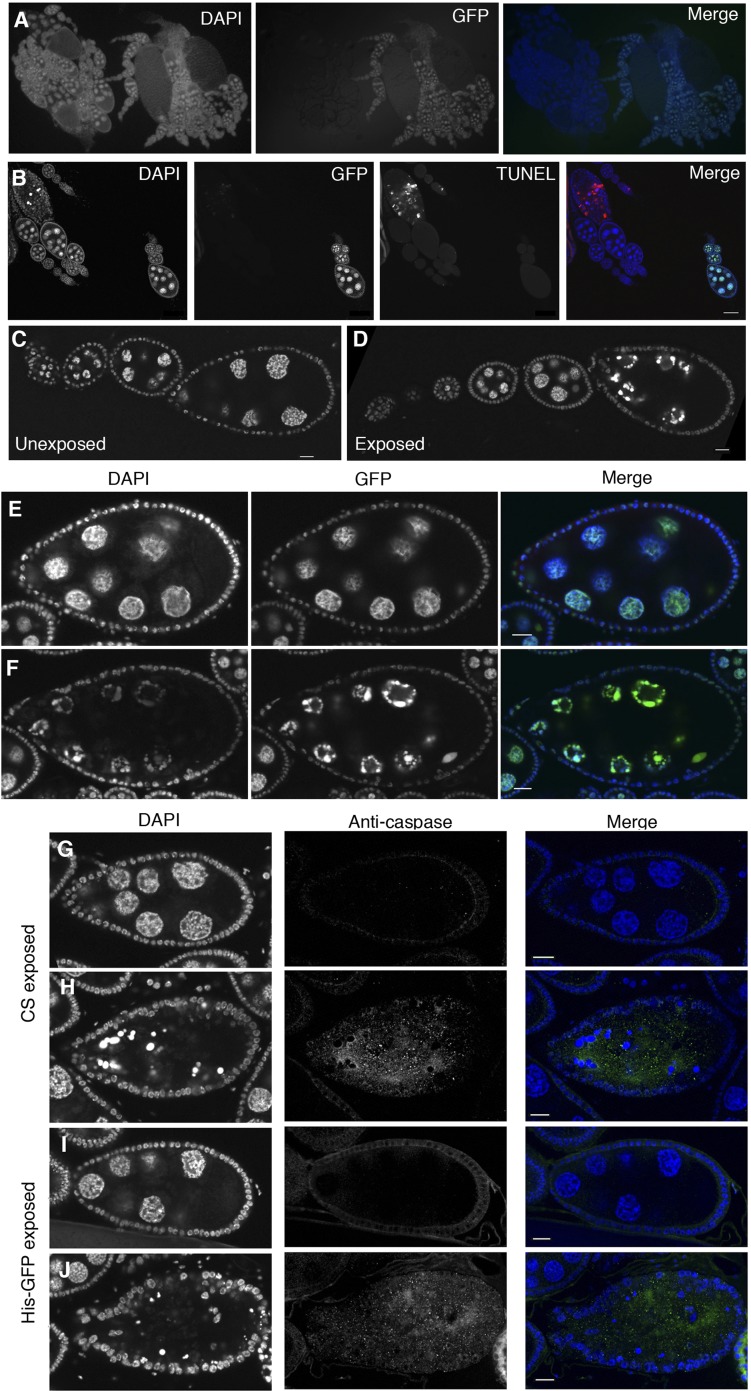
Stage-specific apoptosis is induced following wasp exposure.(A) Canton-S and His-GFP ovaries intermingled are easily distinguishable. (B) Canton-S and His-GFP egg chambers that are undergoing apoptosis are easily distinguishable by using DAPI or TUNEL. (C to D) His-GFP unexposed/exposed ovary chain corresponding to Figure 3E,F, visualized using the GFP channel. (E to F) DAPI and His-GFP images of TUNEL-stained egg chambers corresponding to Figure 3I,J. (G to H) Canton-S exposed egg chambers stained with DAPI and anti-caspase. (I to J) His-GFP exposed egg chambers stained with DAPI and anti-caspase. Scale bars are 20 μm.